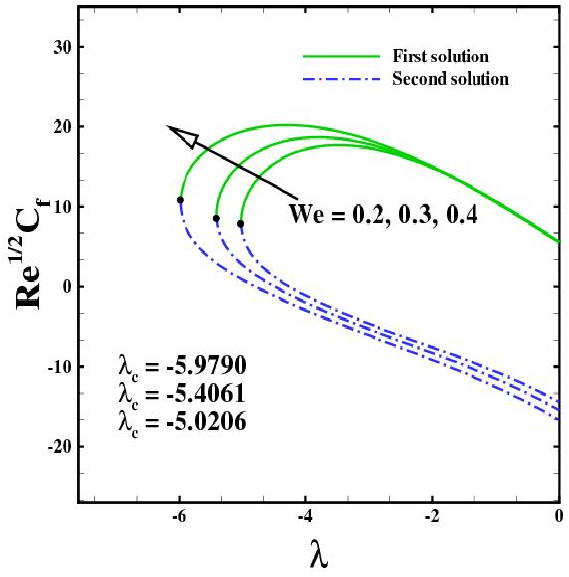
Figure 4. Influence of Re − 1/2 C_f with λ for various values of We and S = 5, β = 0.3, n = 2, M = Ec = 0.5, A = B = 0.1, and Pr = 3.